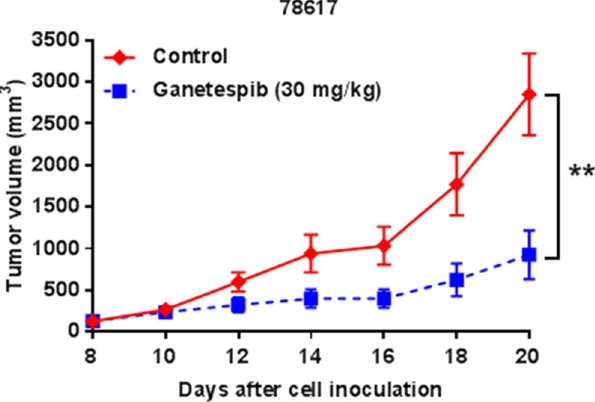
Figure 7. Ganetespib significantly inhibits ErbB2-overexpressing mammary tumors in vivo in a syngeneic transplantation mouse model. 10-week-old MMTV-ErbB2 mice (N = 6 mice per group) were subcutaneously injected with 78617 cells for syngeneic tumor growth. Once tumors were palpable 8 days after the initial tumor cell inoculations, ganetespib (30 mg/kg) was administered via i.p. injections every other day until the 20 th day after tumor cell inoculations. Tumor volumes were measured every 2 days. All values are presented as the means ± S.E. ( ** P ≤